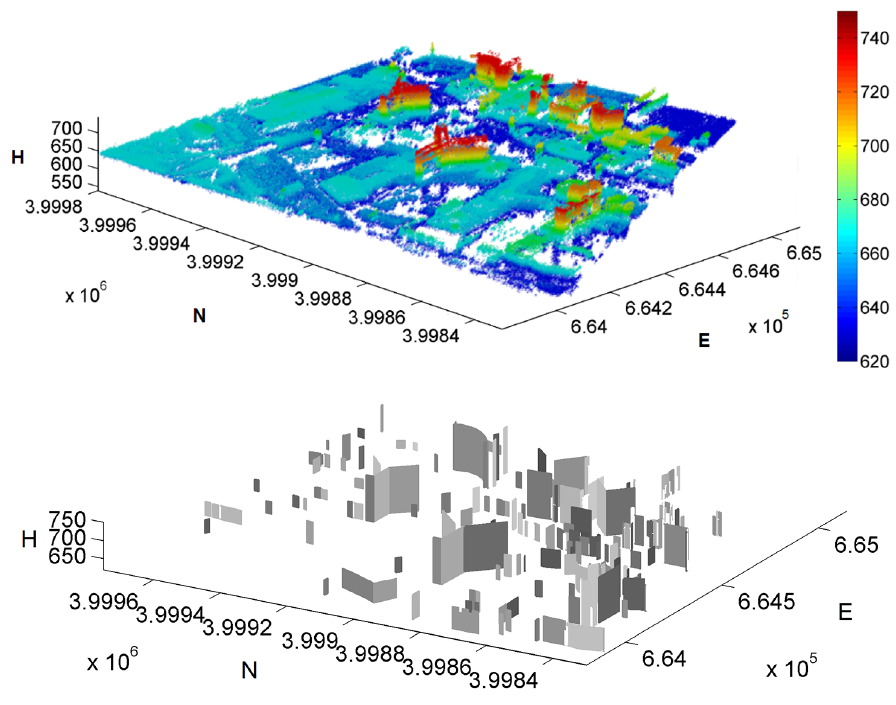
Figure 8. A TomoSAR point cloud of Las Vegas (upper), and the reconstructed facades (lower) [45]. The color of the point cloud represent its height above